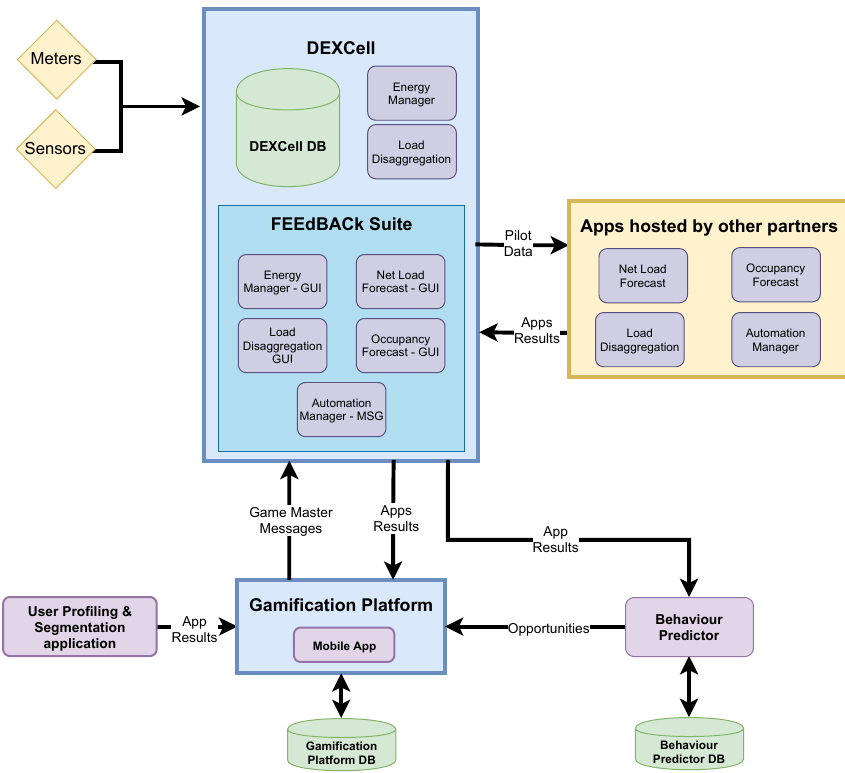
Figure 2. FEEdBACk Suite integration block-scheme in the FEEdBACk ICT-based